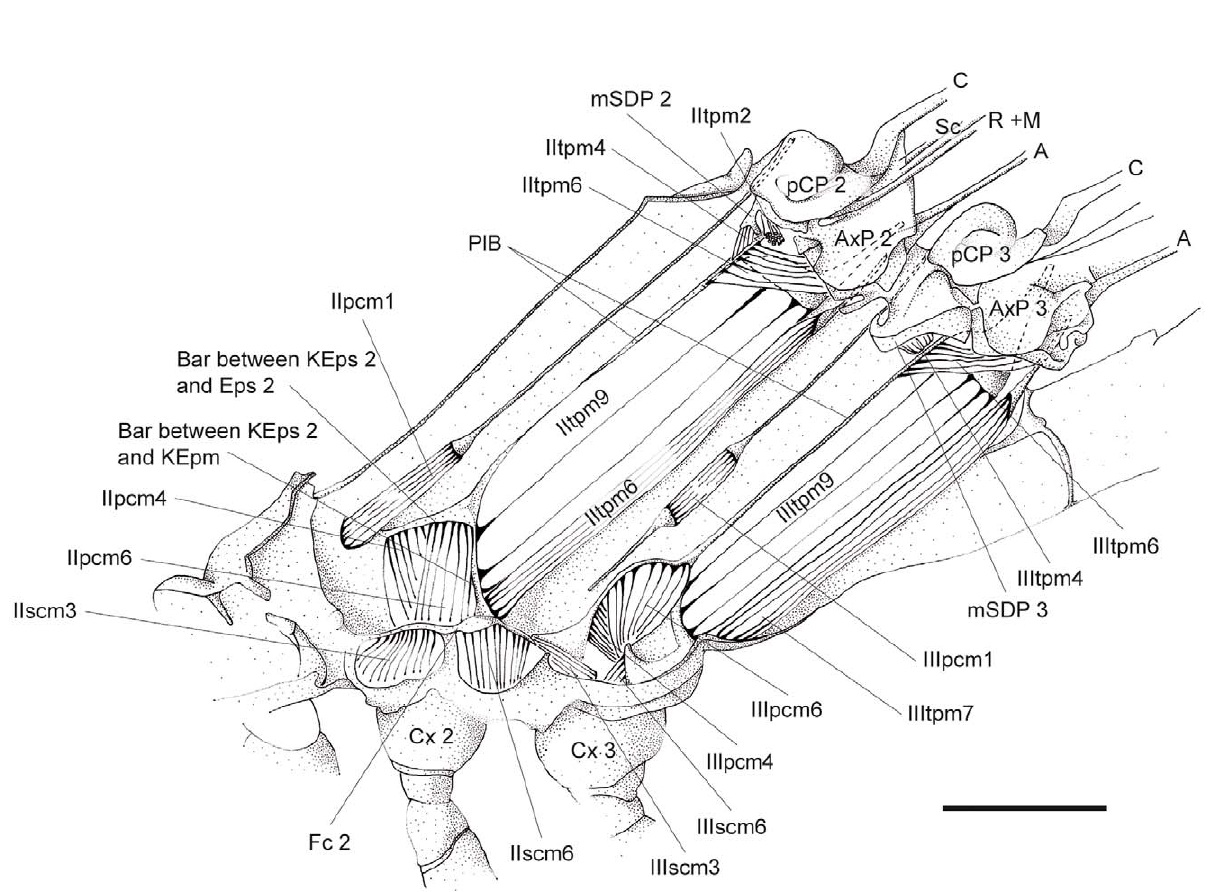
Figure 4. P.nymphula , lateral thorax musculature, longitudinal cut, right. Abbreviations: A – anal vein, AxP – axillary plate, C – costa, Cx – coxa, Eps – episternum, KEpm – katepimerom, KEps – katepisternum, M – media, mSDP - mediane semi-detached scutal plate, pCP – proximale costal plate, PlB - pleuralbar, R – radius, Sc – subcosta.